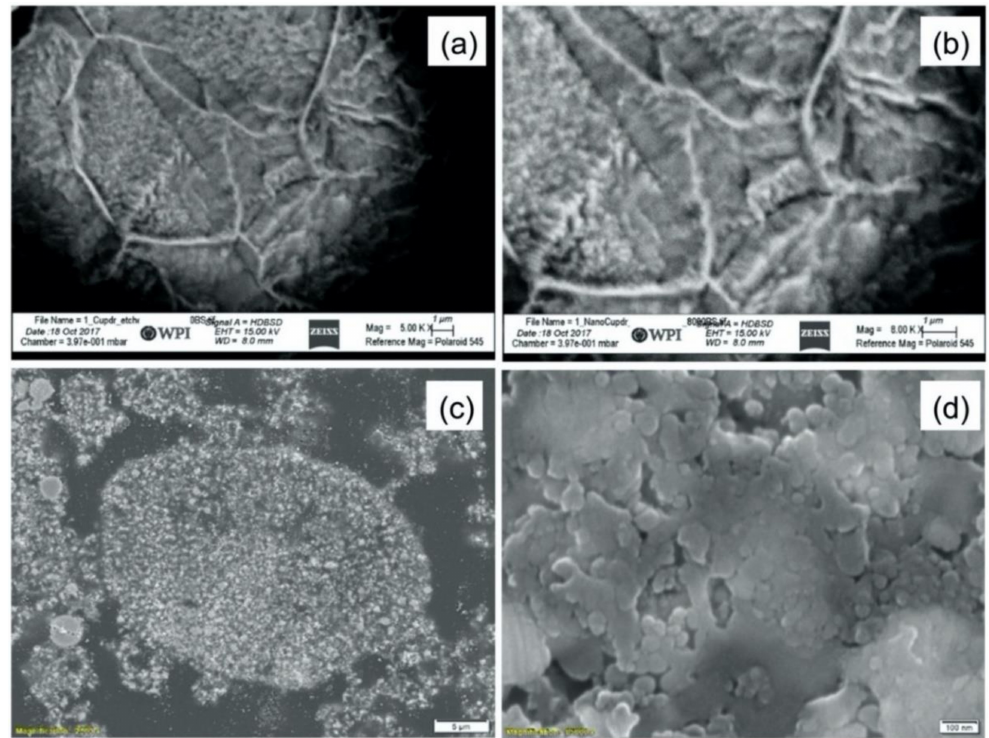
Figure 2. Micrographs were observed using a HDBS electron detector for the chemically etched GA powder cross-sections as shown in ( a ) and ( b ). At the same time, similar micrographs were obtained for the spray-dried powder in ( c ) and ( d